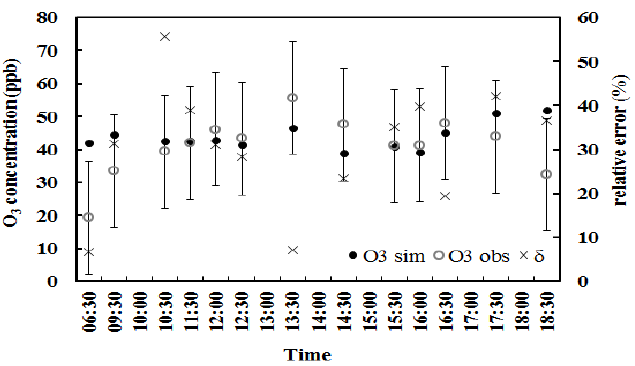
Figure 4. Same as Figure 3 but for situation